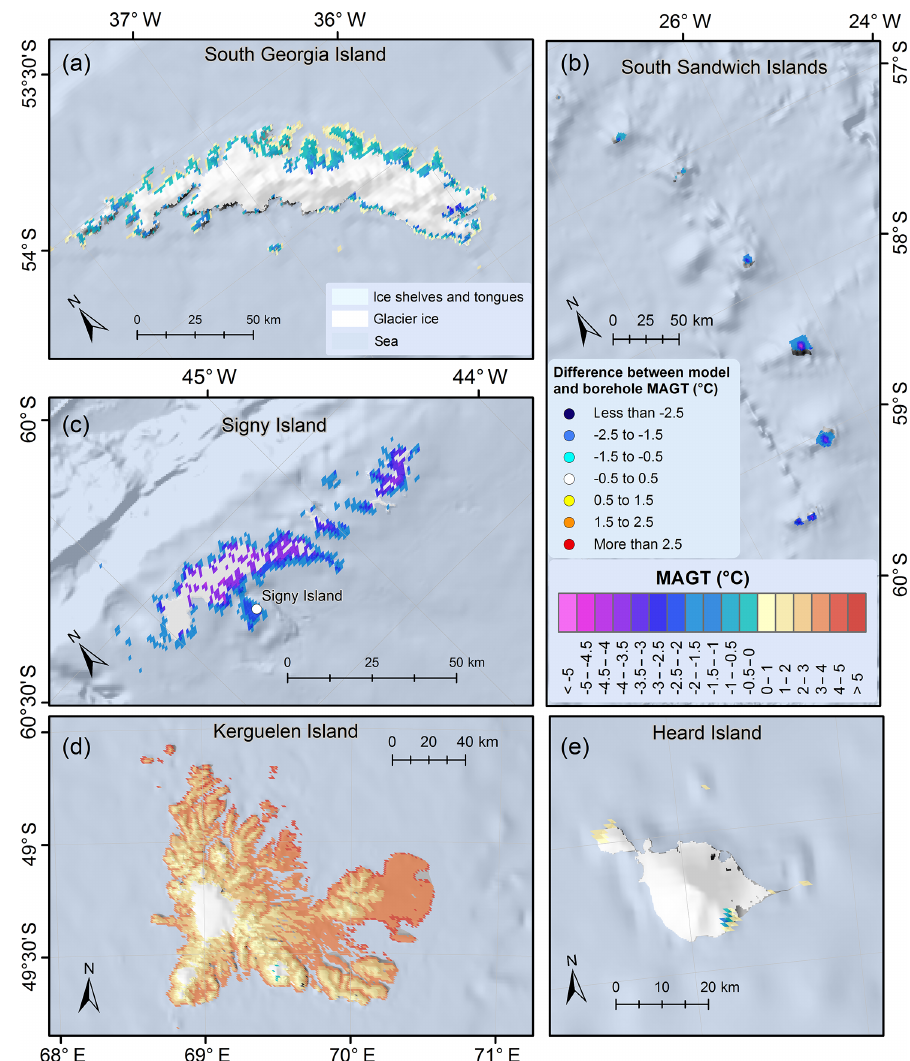
Figure 14. Permafrost temperature maps of Antarctic islands and difference between borehole and modelled MAGT. Legends are valid for all panels. See Fig. 1 for location of panels (a) , (b) , (c) , (d) and (e) . Note: the MAGT colour ramp is different from other